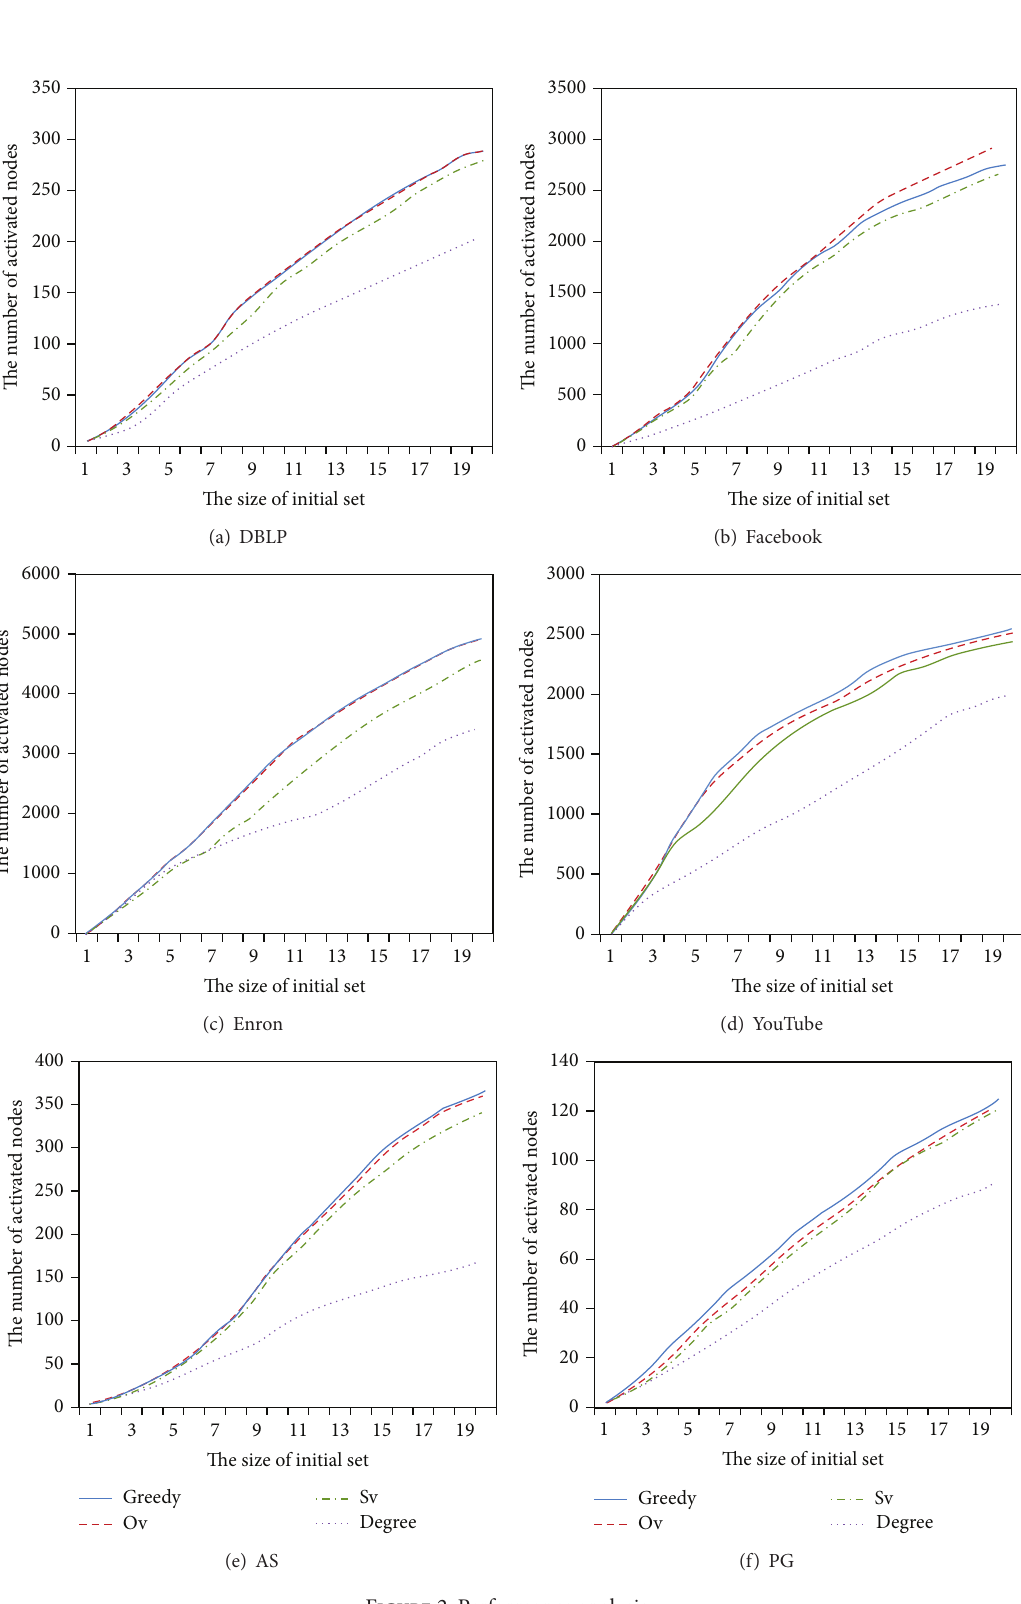
Figure 2: Performance